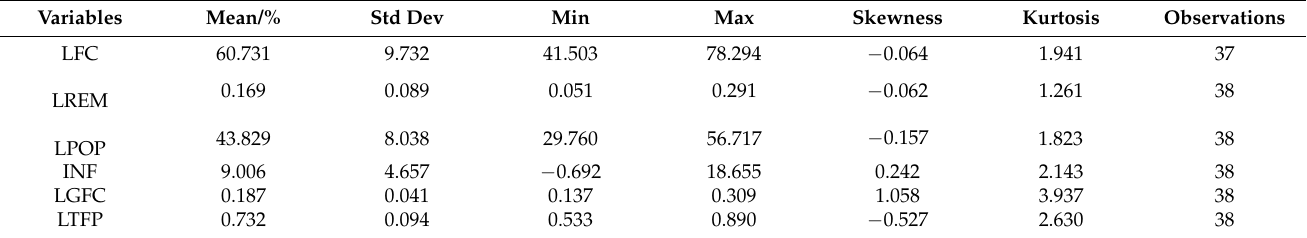
Table 2. Summary